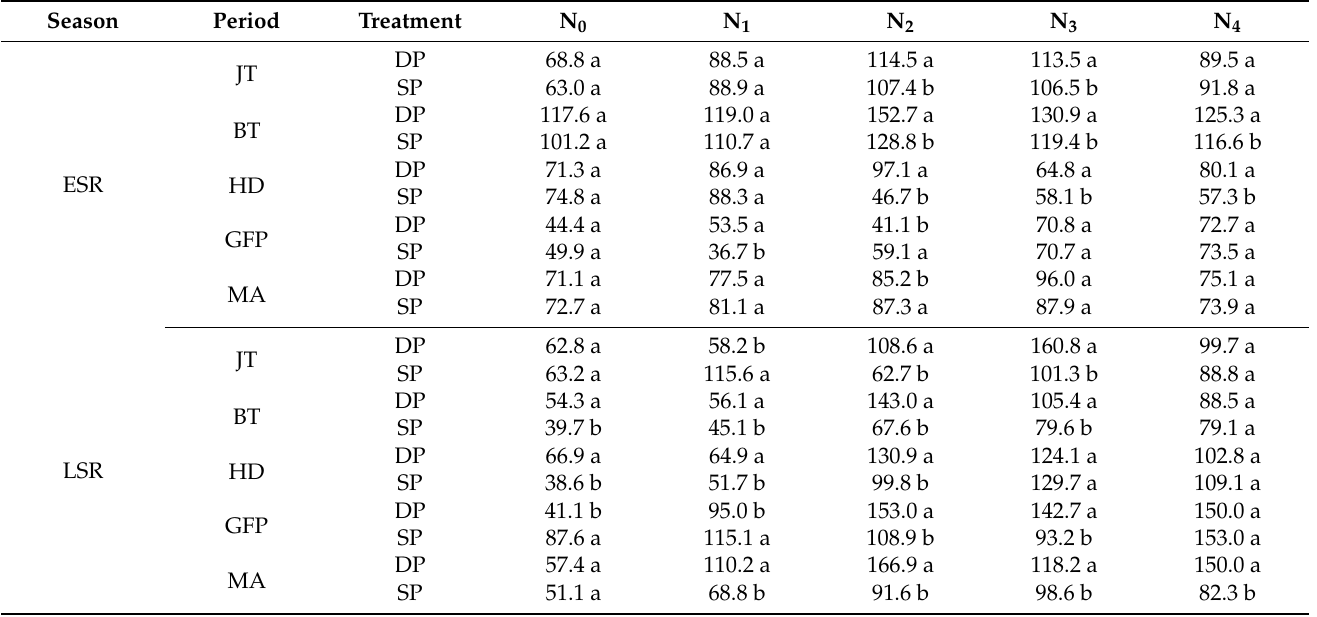
Table 3. Net soil mineralized nitrogen cultured for two weeks at different stages of double cropping rice under different fertilization rates (mg N kg –1 dry